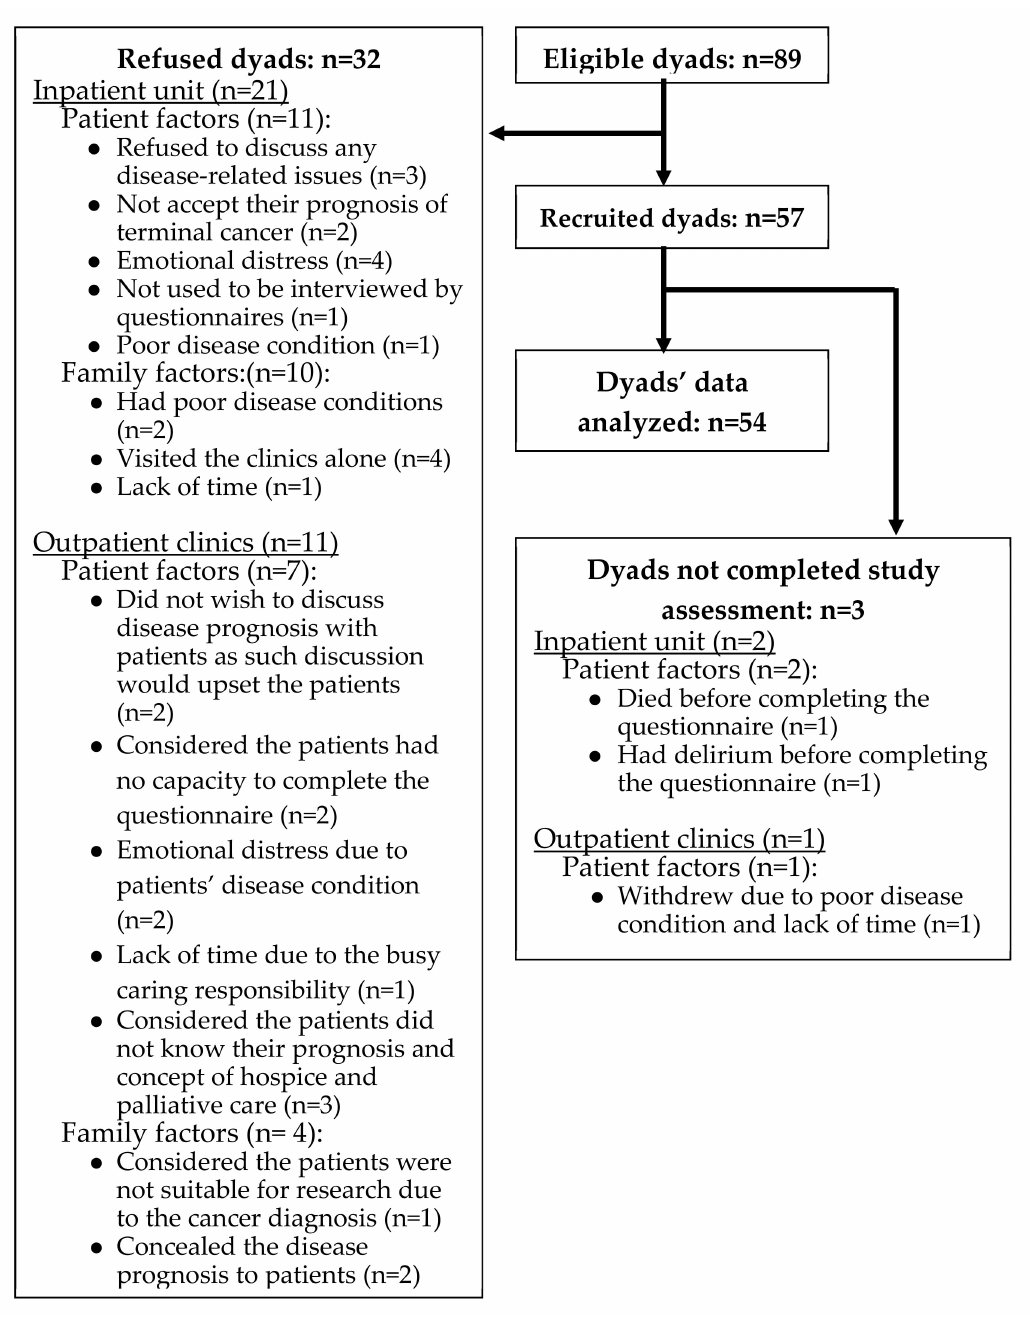
Figure 1. Flow diagram of study